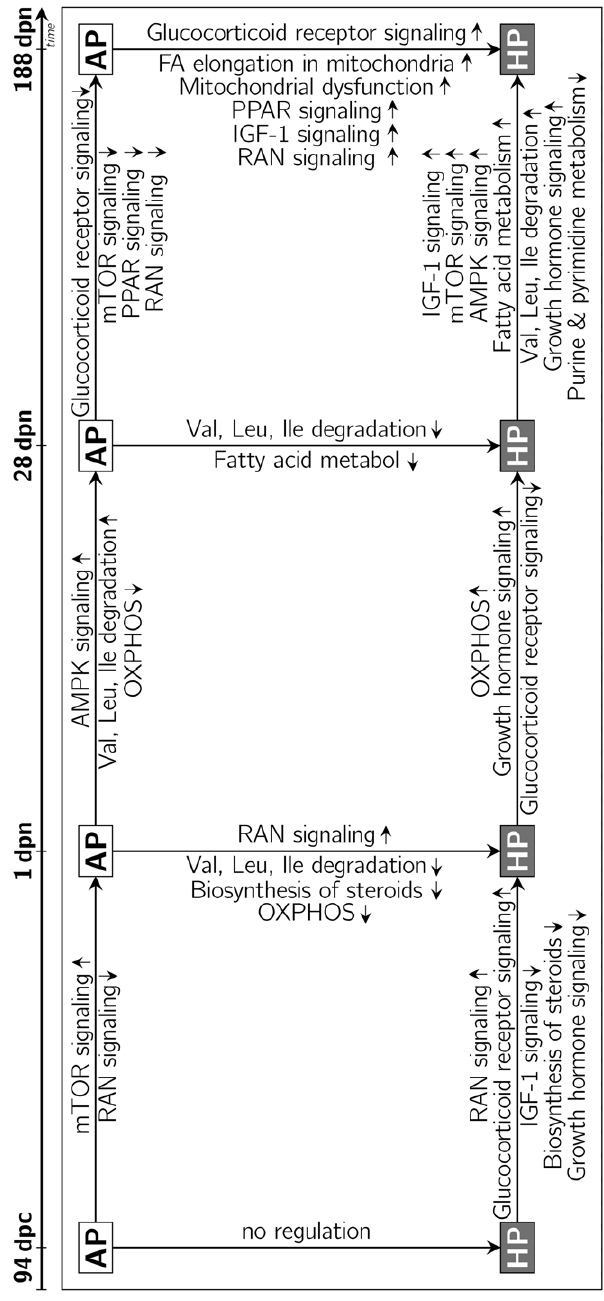
Figure 2. Regulated pathways in liver tissue between ontoge- netic stages and maternal diets. Listed pathways between stages in AP offspring (white boxes) indicate the appropriate ontogenetic development, which doesn’t occur in HP offspring (black boxes) at the corresponding developmental period. Pathways between the HP stages indicate processes and metabolic regulations, which occur in the HP offspring but not in the AP offspring in the corresponding developmental period. The differences in gene regulation dependent on diet and ontogenetic stage indicate fetal programming in terms of developmental and metabolic disorders (arrows between boxes show direction of the comparisons; small arrows to top=up-regulated, small arrows to bottom=down-regulated pathways; mTOR, mammalian target of rapamycin; RAN, Ras-related nuclear protein; IGF-1, insulin- like growth factor; PPAR, peroxisome proliferator receptor; AMPK, AMP- activated kinase).